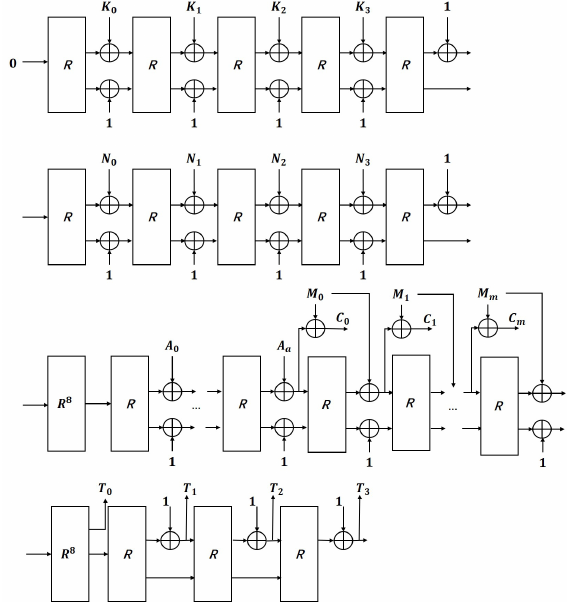
Figure 1: The construction of